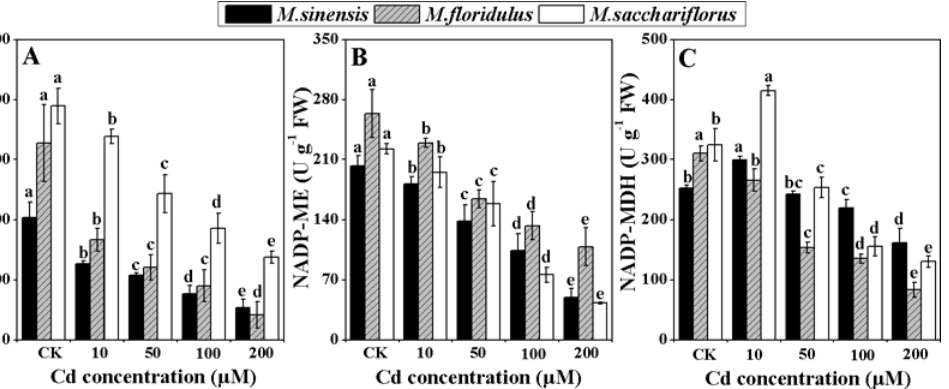
Fig 5. Change in C4 photosynthetic enzymes activities. (A) Phosphoenolpyruvate carboxylase (PEPC), (B) NADP-malate enzyme (NADP-ME), (C) NADP-malate dehydrogenase (NADP-MDH). Data are mean ± SD (n = 3). Different letters indicate a significant difference at P < 0.05.